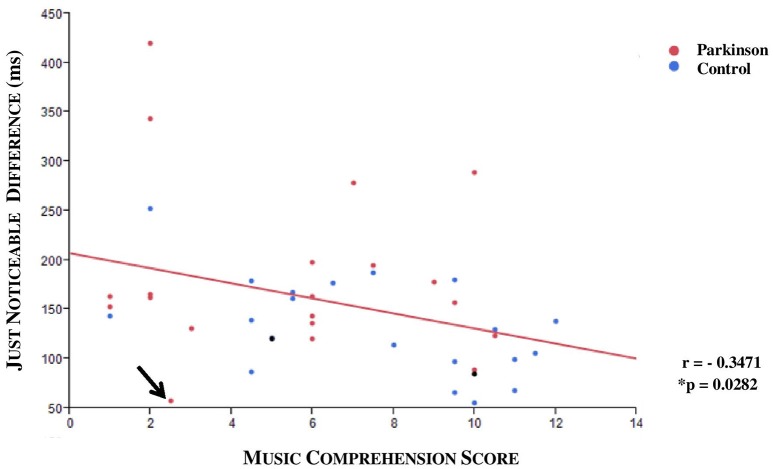
Scatterplot with regression line (red): JND and musical comprehension. An outlier was identified (arrow). A negative correlation was displayed (r = −0.3471; *p = 0.0282, n = 40; both DBS patients who were excluded from the analysis are also shown in the graphic as black points).